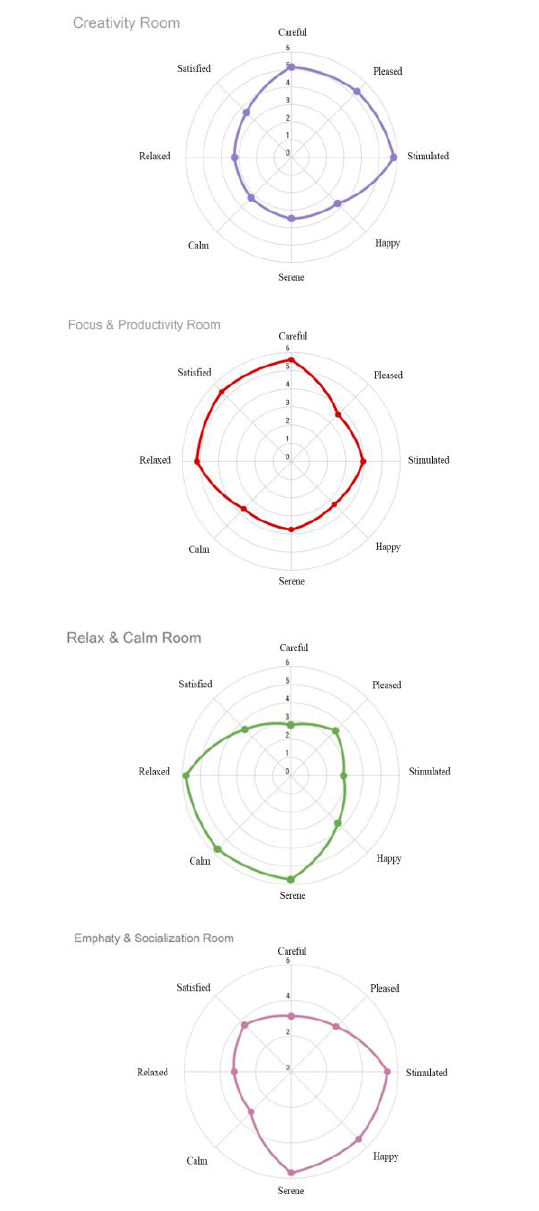
Figure 7. Kyviat diagram in the respective